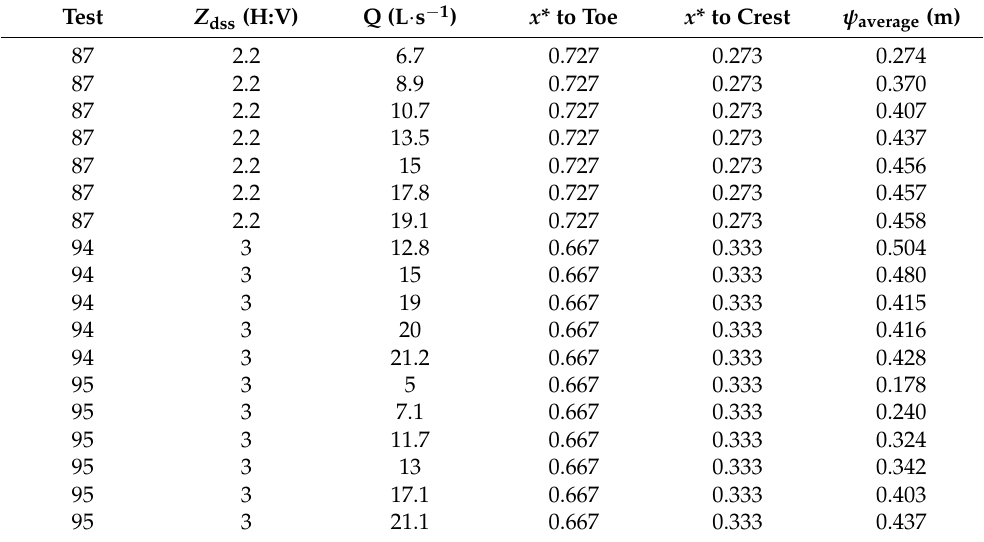
Table A3. Summary of the average hydraulic pressures ψ at the base of the physical models n o 87, 94, and 95 for a transversal section roughly located at x ∗ = 0.3 (30% of the base length from the